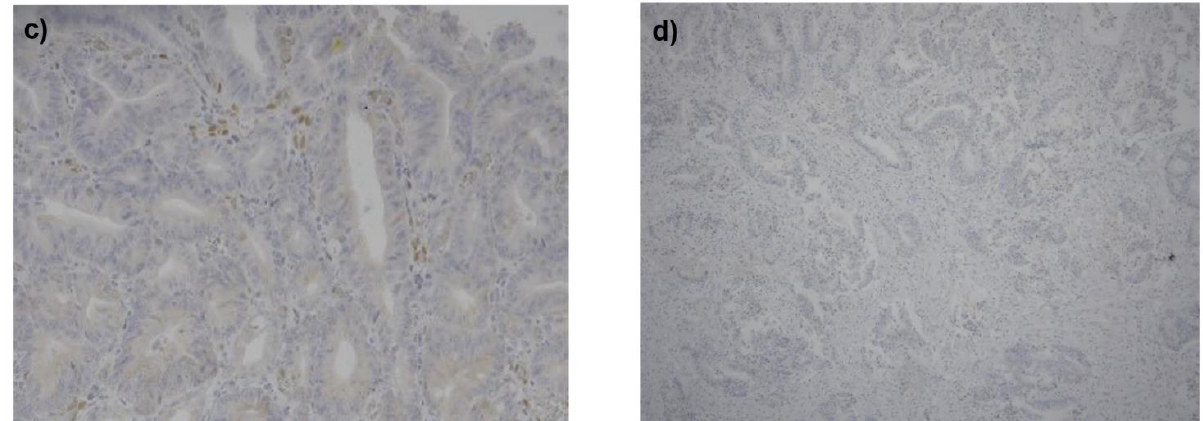
Figure 1. Staining images of phosphorylated STAT3 in cancer cells. ( a ) Expression of phosphorylated STAT3 in lung cancer developed by a control patient (score 5.33), scale bar=50 μm. ( b ) Expression of phosphorylated STAT3 in gastric cancer developed by a psoriasis patient (score 4), scale bar=50 μm. ( c ) Expression of phosphorylated STAT3 in gastric cancer developed by a psoriasis patient (score 3.33), scale bar=50 μm. ( d ) Expression of phosphorylated STAT3 in gastric cancer developed by a control patient (score 0), scale bar=100 μm